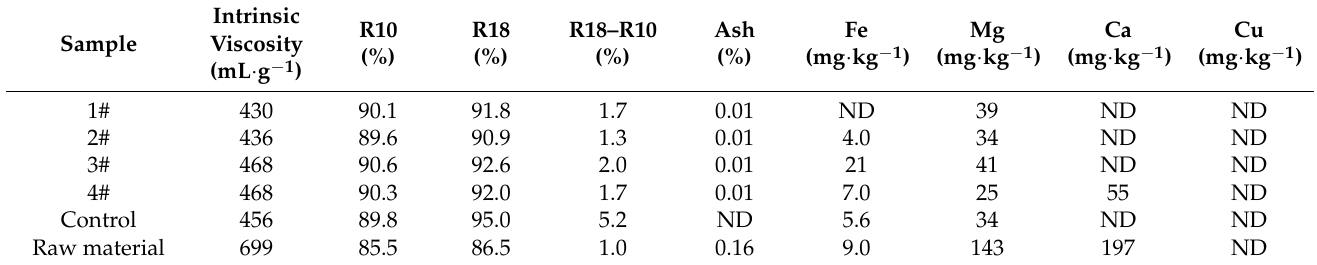
Table 3. Characterization of pulp properties.